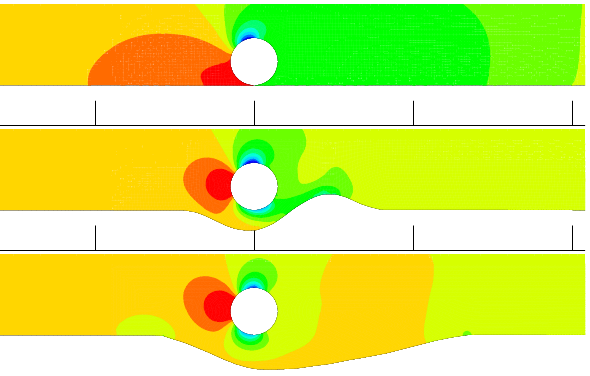
Figure 7. Three cases are simulated corresponding to three bed profiles; the top, middle, and bottom profiles correspond to profiles 1, 3, and 5, respectively, of the experiments in [22]. The simulated pressure contours are also displayed.